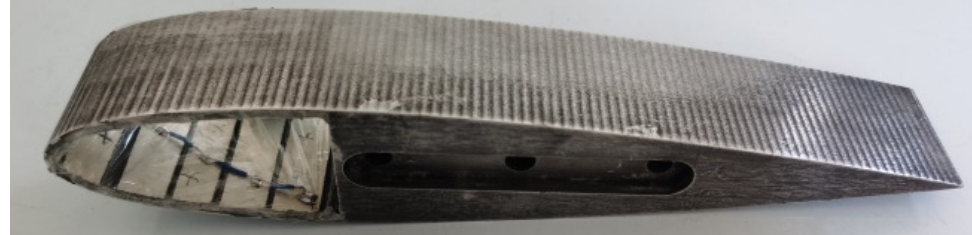
Figure 7. Sample of the